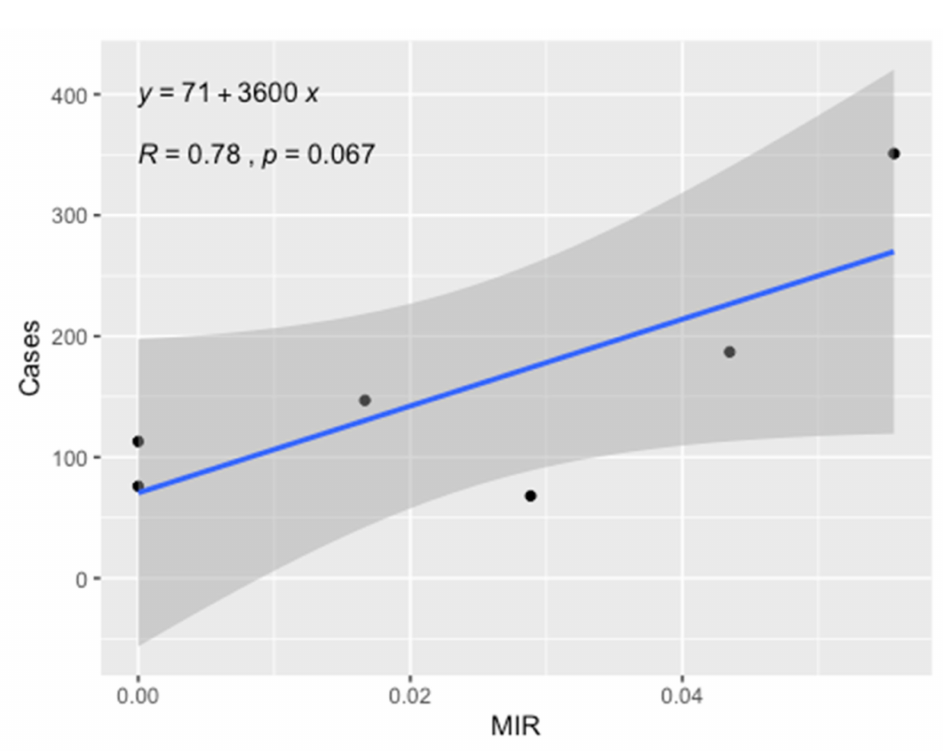
Figure 3. Correlation between MIRs and ZCL cases. Leishmania Sequencing and Phylogenetic